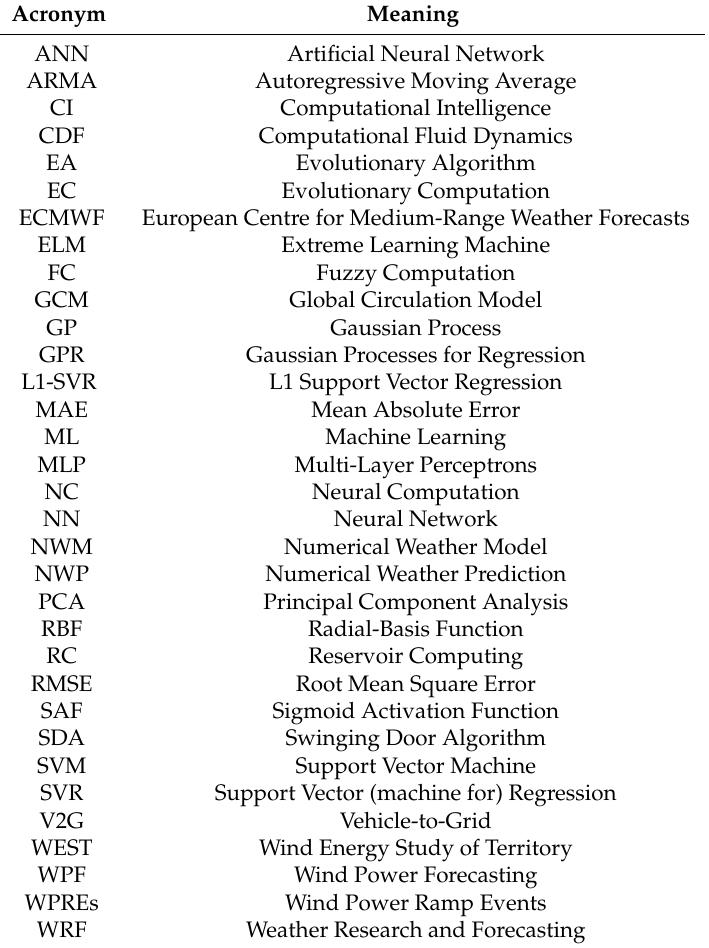
Table 1. List of acronyms used throughout this research